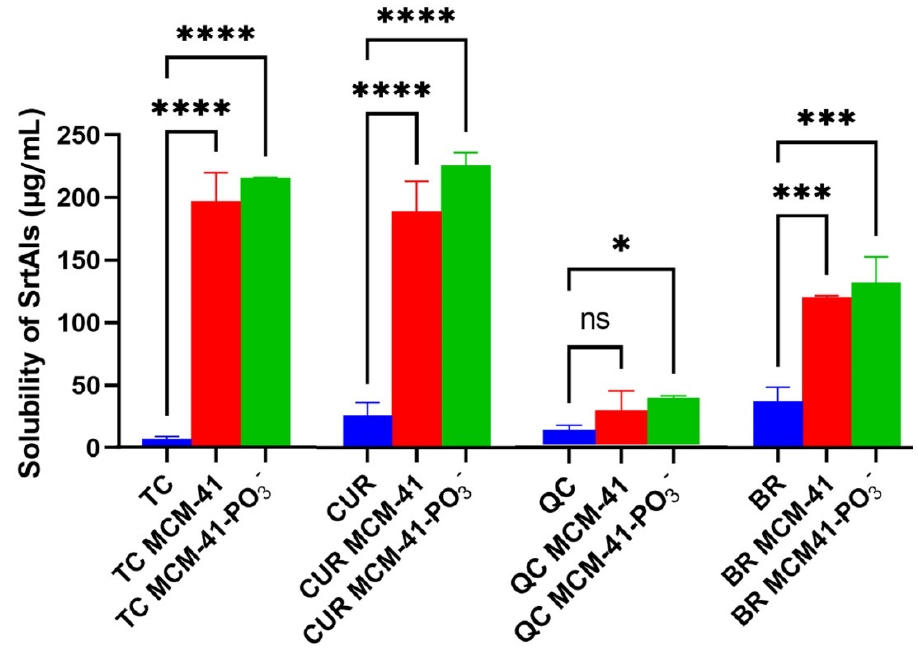
Figure 4. Aqueous solubility of SrtAIs alone and loaded into MCM-41 and MCM-41-PO 3 − MSNs ( n = 3; data presented as mean ± SD; statistics are presented as * p < 0.05, *** p < 0.001, **** p < 0.0001, following ANOVA and Tukey’s post-hoc test.